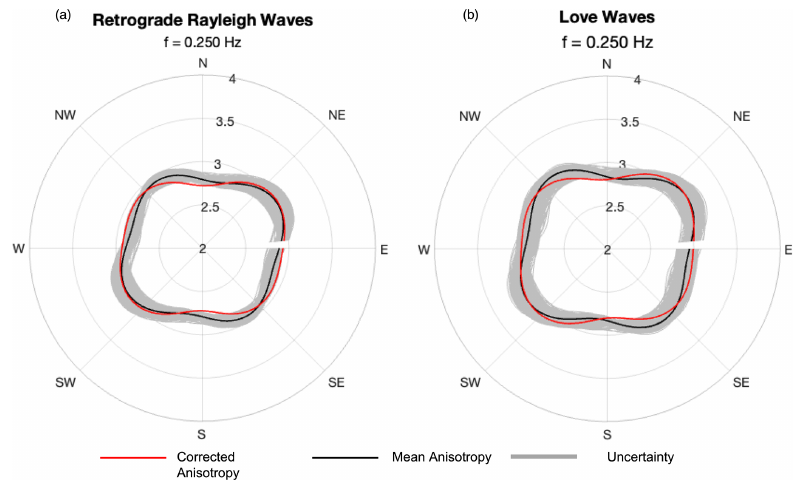
Figure 7. Polar plots of mean anisotropy (black) and anisotropy uncertainty (grey) where the y axis is the velocity. (a) Retrograde Rayleigh waves for a frequency of 0.25Hz with the corrected curve (red) and mean anisotropy (black). (b) Love waves for 0.25Hz, with corrected curve and mean anisotropy (black).